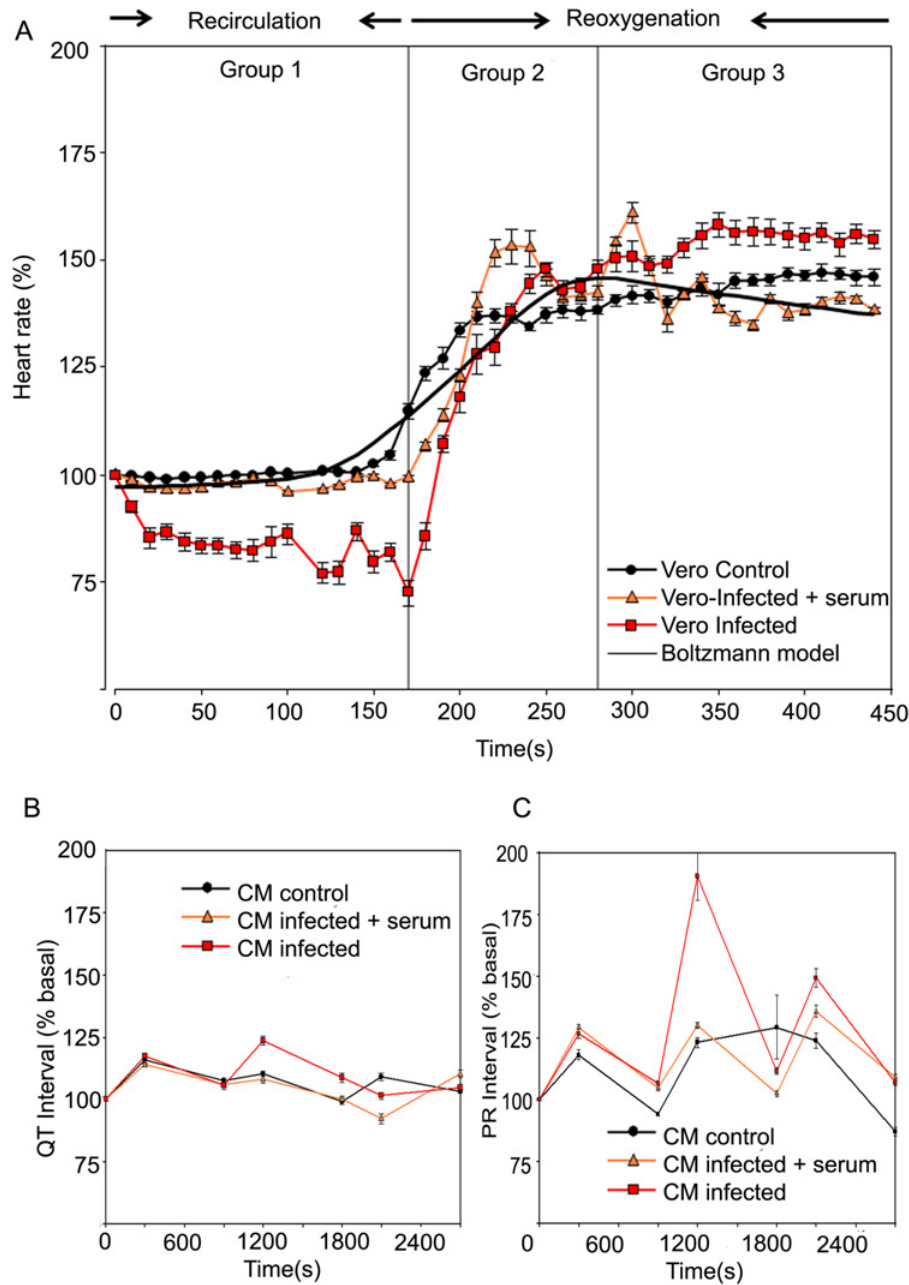
Fig 3. (A) Fixed models for heart rate (%) kinetics during the recirculation-reoxygenation protocol for the three different conditions studied. Percentage ± Confidence Interval95% were taken from the middle of the period of perfusion with conditioned medium (2.5 min) until the early recovery phase (5 min). These groups were comparing in three perfusion conditions (CM control, CM infected and CM infected + serum). In CM infected plus serum, medium was pre-incubated with chagasic patient serum (1:10) for 30 min at 37°C and centrifuged at 3000 per g for 10 min before perfused. Groups were defined as the heart rate in different frame times; Group 1, from 0 to 170 s, Group 2, from 171 to 280 s and, Group 3, higher than 280 s. The Boltzmann fitting is showed in solid line. (B) Fixed models for QT intervals during the recirculation- reoxygenation protocol for the three different conditions studied. (C) Fixed models for PR intervals during the recirculation-reoxygenation protocol for the three different conditions studied.